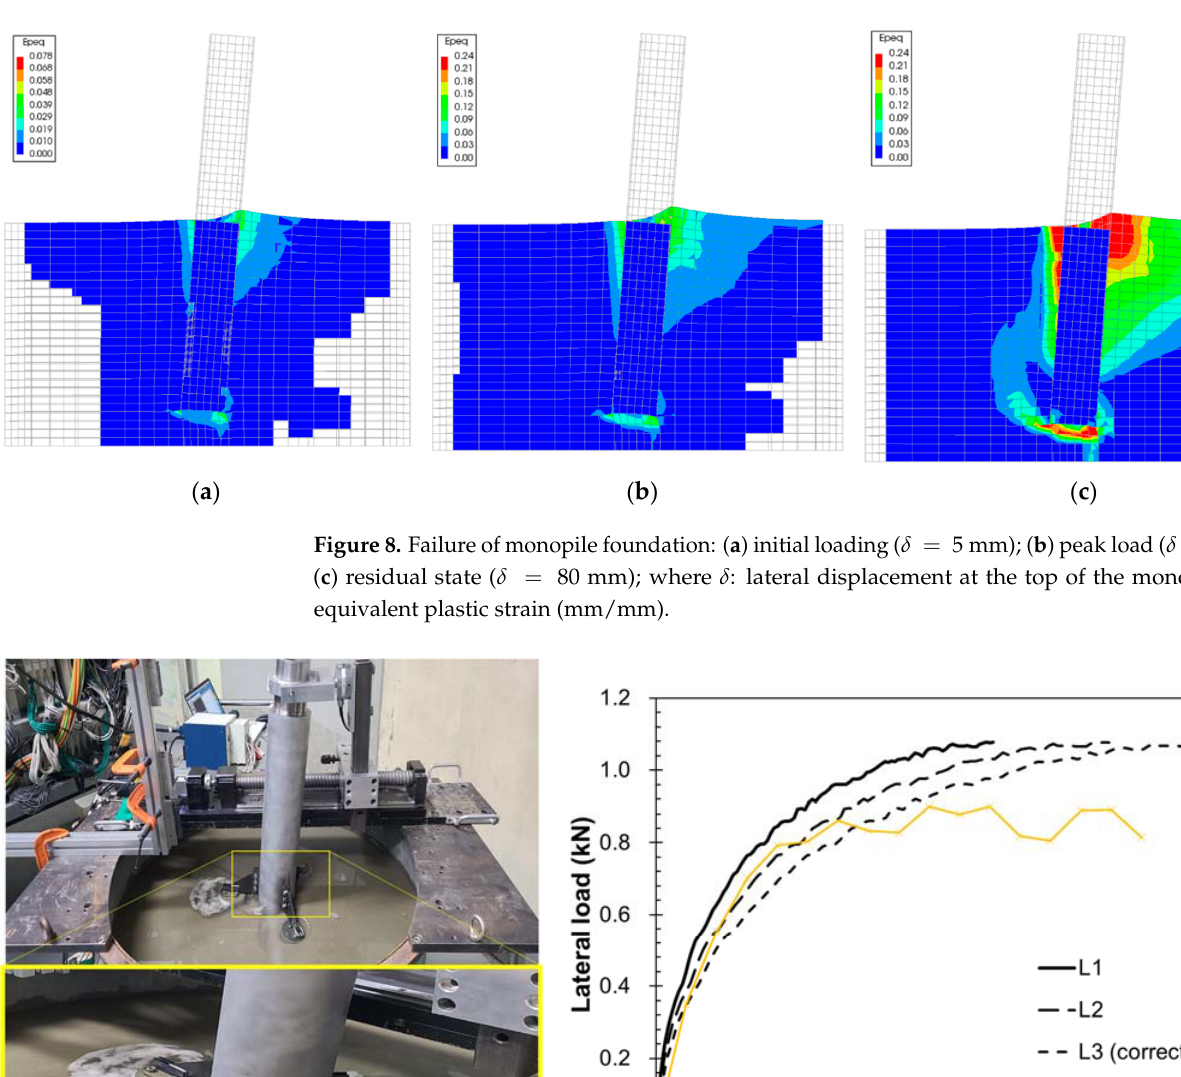
( c ) Figure 10. Failure of hybrid monopile foundation: ( a ) initial loading ( 𝛿 (cid:3404) 5 m m); ( b ) peak load ( 𝛿 (cid:3404) 45 mm); ( c ) residual state ( 𝛿 (cid:3404) 80 mm); where 𝛿 : lateral displacement at the top of the monopile, Epeq: equivalent plastic strain (mm/mm).